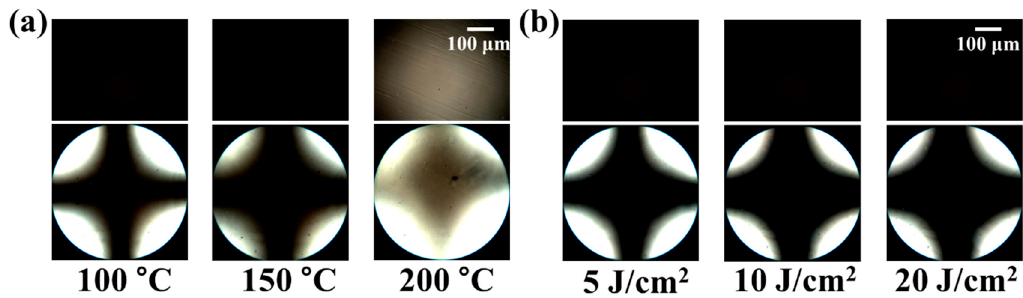
Figure 7. Orthoscopic (top) and conoscopic (bottom) polarized optical microscopy (POM) images of the LC cells made using PEOP films, ( a ) after thermal treatment at 100, 150, and 200 °C for 10 min and ( b ) UV treatment at 5, 10, and 20 J/cm 2 , respectively.